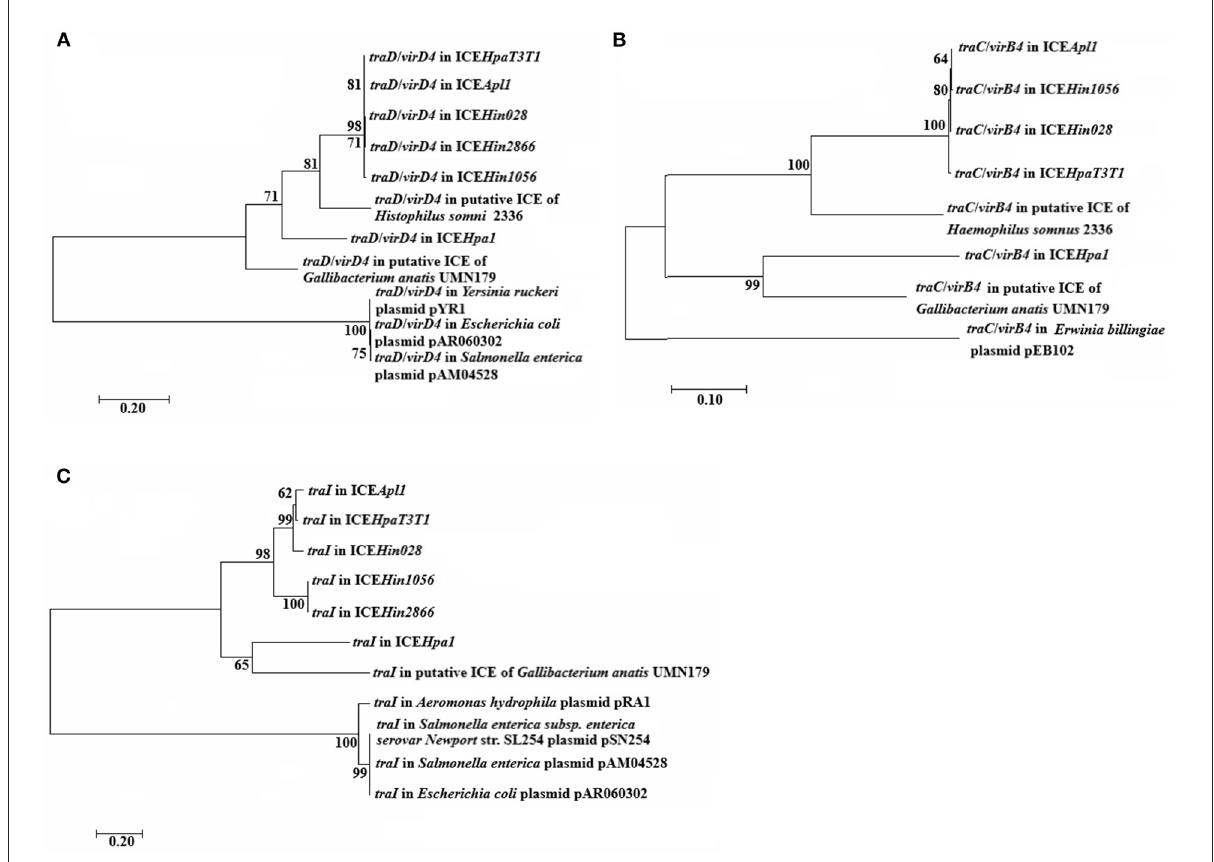
FIGURE3 Phylogenetic analysis of (A) traD / virD4 , (B) traC / virB4 , and (C) traI genes. Amino acide sequences of the indicated these core genes were used to generate the phylogenetic trees shown. Bootstrap values are indicated at branch points. The individual scale bars represent genetic distances and reflect the number of substitutions per